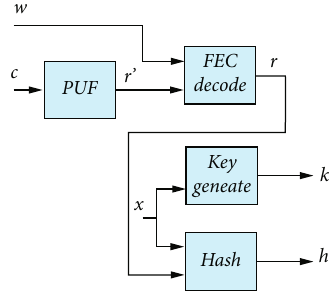
Figure 5: Structure of the system used to obtain secret session key and authentication hash at the client side.